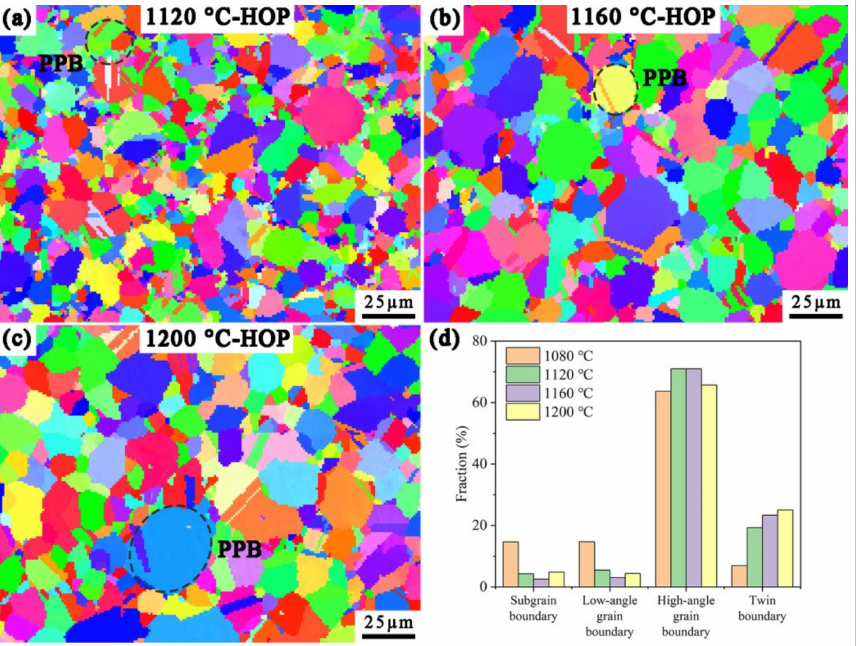
Figure 13. Local magnification in Figure 12 of the samples: ( a ) 1120 ◦ C-HOP; ( b ) 1160 ◦ C-HOP; ( c ) 1200 ◦ C-HOP and ( d ) grain boundary